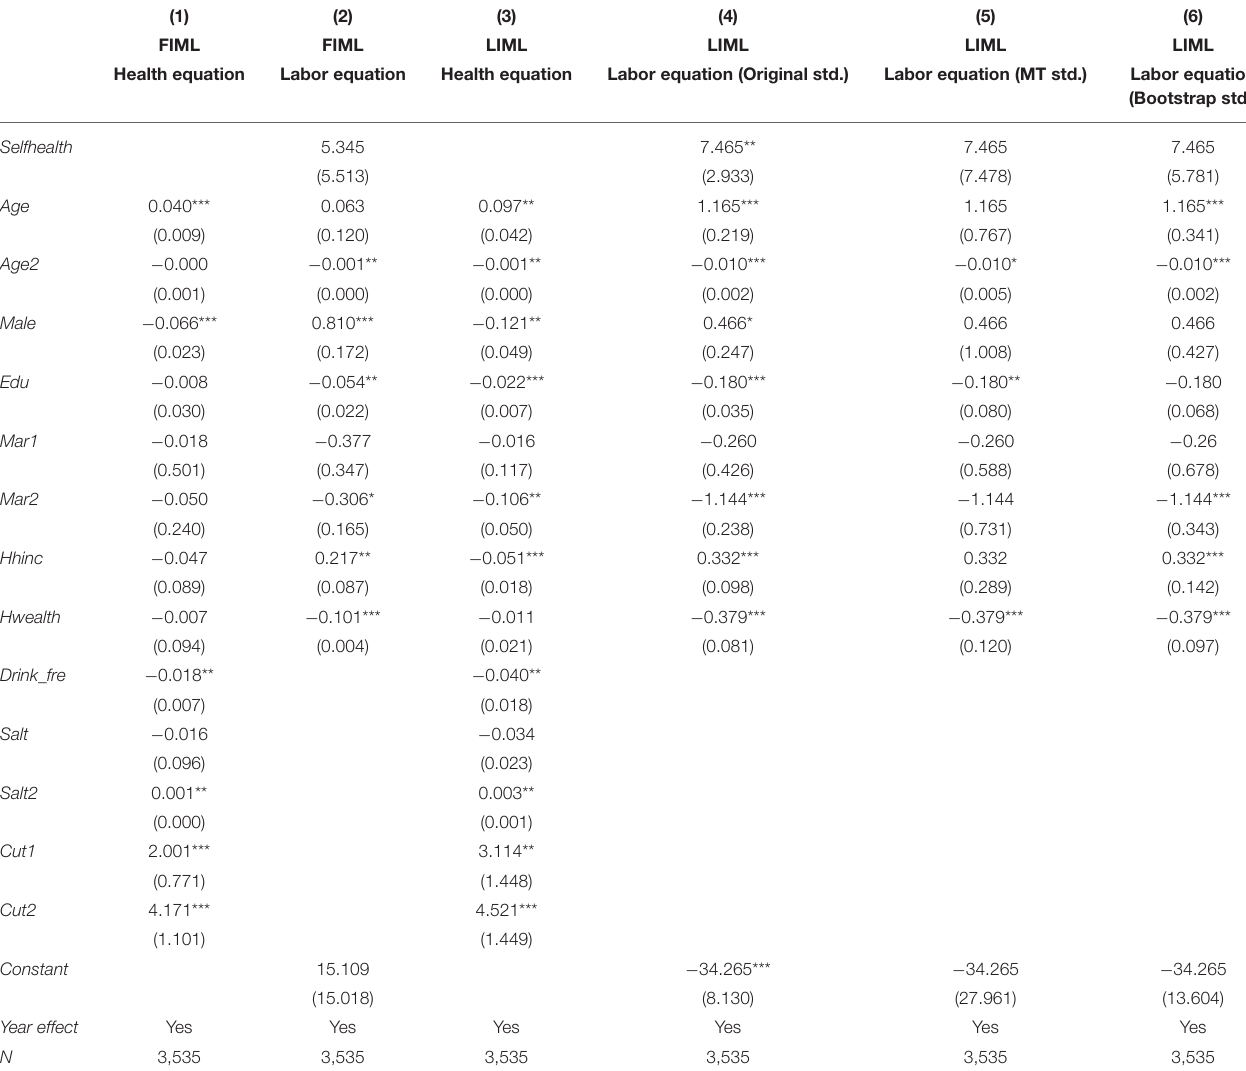
TABLE 5 | The effect of health on the elderly’s labor supply (using the subjective indicator of health: Self-reported health).